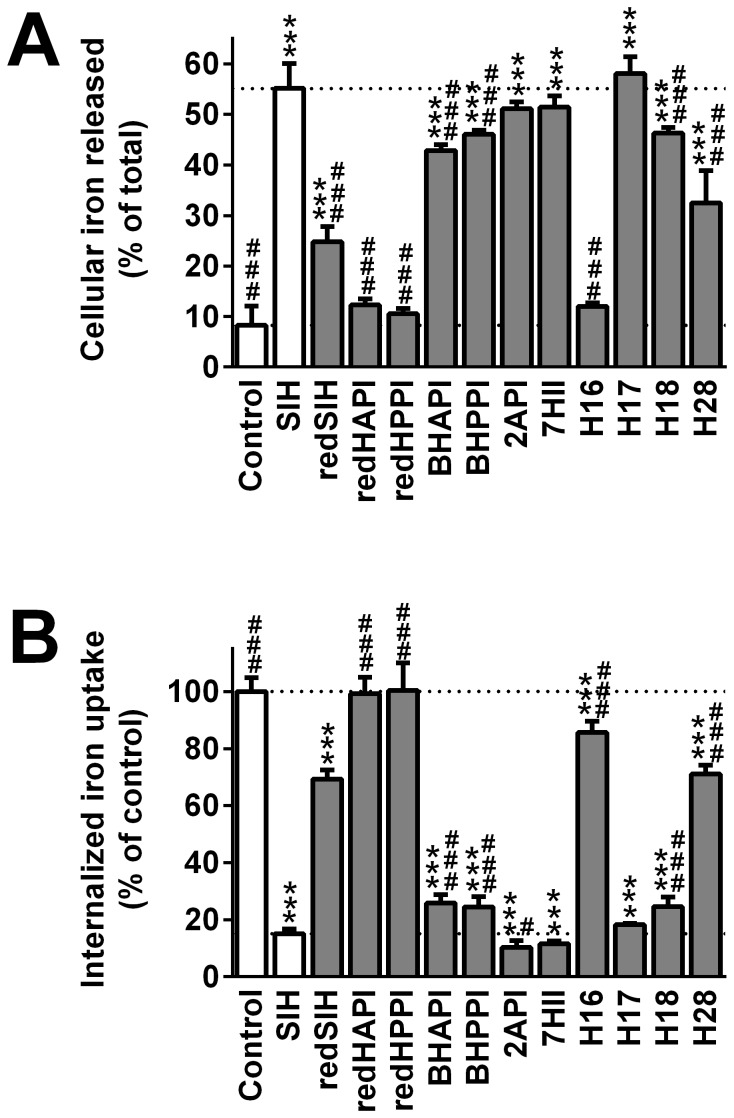
The effect of SIH and its analogs on 59Fe mobilization from pre-labeled MCF-7 cells (A) and on internalized 59Fe uptake from 59Fe2-transferrin (Tf) by MCF-7 cells (B).(A) The ability of the ligands to promote 59Fe mobilization from MCF-7 cells was performed by first prelabeling the cells with 59Fe2-Tf (0.75 µM) for 3 h/37°C, followed by washing and then reincubation for 3 h/37°C with either control medium alone, or control medium containing the chelator (25 µM). (B) Inhibition of 59Fe uptake from 59Fe2-Tf by MCF-7 cells by chelators was performed by incubating cells for 3 h/37°C with 59Fe2-Tf (0.75 µM) in the presence or absence of the chelator (25 µM). Results are Mean ±SD (n≥3 experiments). Statistical significance (ANOVA): * p<0.05, ** p<0.01, *** p<0.001 compared to the control (untreated) group, and # p<0.05, ## p<0.01, ### p<0.001 compared to the reference chelator, SIH.